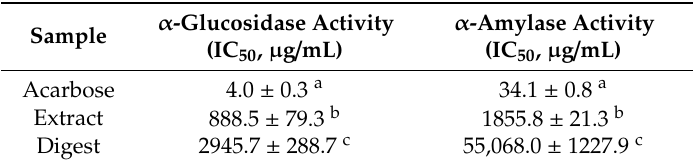
Table 3. Bioaccessibility of inhibitors of carbohydrases in Tannat grape skin hydro-alcoholic-acid extract. IC 50 , half maximal inhibitory